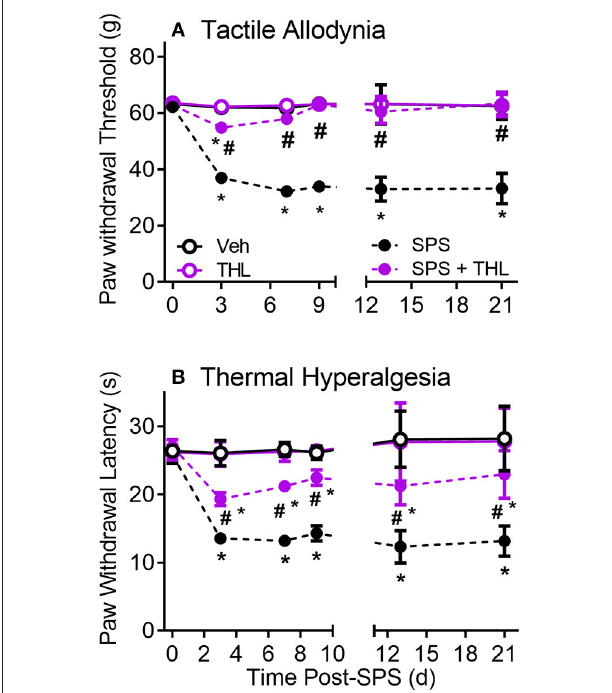
FIGURE 2 | Thalidomide (THL) prevents development of SPS-induced tactile allodynia (A) and alleviates thermal hyperalgesia (B) . Single daily injections of thalidomide (50 mg/kg, i.p.) from days 1-5 of SPS prevents development of allodynia and reduces thermal hyperalgesia. Sensitivity of THL-treated rats did not differ from that of Veh-treated rats. Results reflect mean ± 95% CI of 9 rats/group through day 9 and 3 rats/group at days 13 and 21, group differs from Veh * p < 0.0001, differs from SPS: # p <